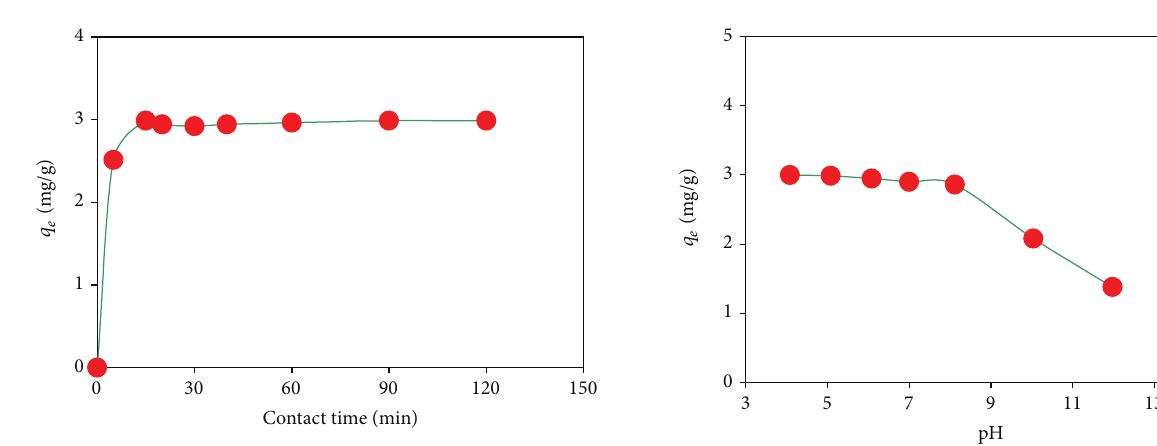
Figure 3: Effect of pH on the of Hg 2+ adsorption of ACCF. (Initial concentration 0.15mg/L, contact time 15min, and ACCF dosage 0.0025 g/L).